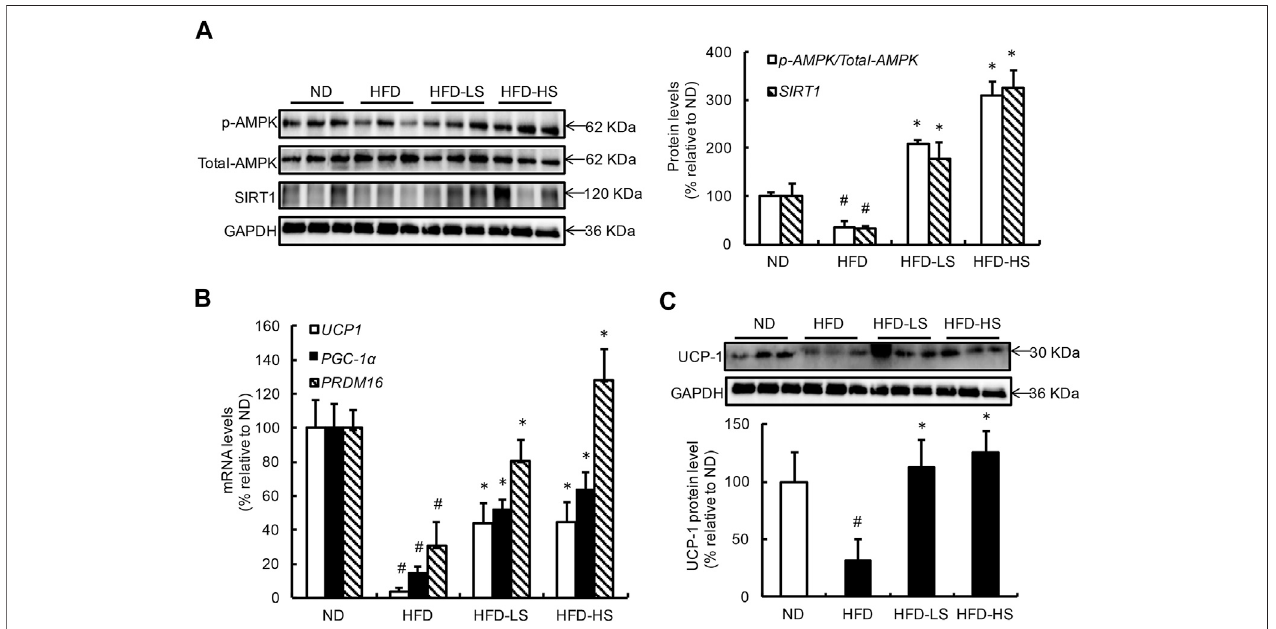
FIGURE 5 | Sal A supplementation improves AMPK-SIRT1 pathway activation and prevents UCP-1 downregulation in eWAT of HFD-fed mice. (A) Results of the Western blot analysis of AMPK signaling in eWAT, including p -AMPK, and AMPK, SIRT1. (B) The gene expressions of UCP1, PGC-1 α , and Prdm16, related to WAT browning. (C) The protein levels of UCP1 and quanti fi cation of the bands. The same internal reference (GAPHD) was used for p -AMPK, AMPK, SIRT1, and UCP1 quantitative analysis, since the results come from the same experiment based on the same batch of loading samples. In order to satisfy the logical rationality of the argument, we put the results in panel (A,C) , respectively. # p < 0.05 vs. the ND group; * p < 0.05 vs. the HFD group. All groups contain 12 animals ( n (cid:1)